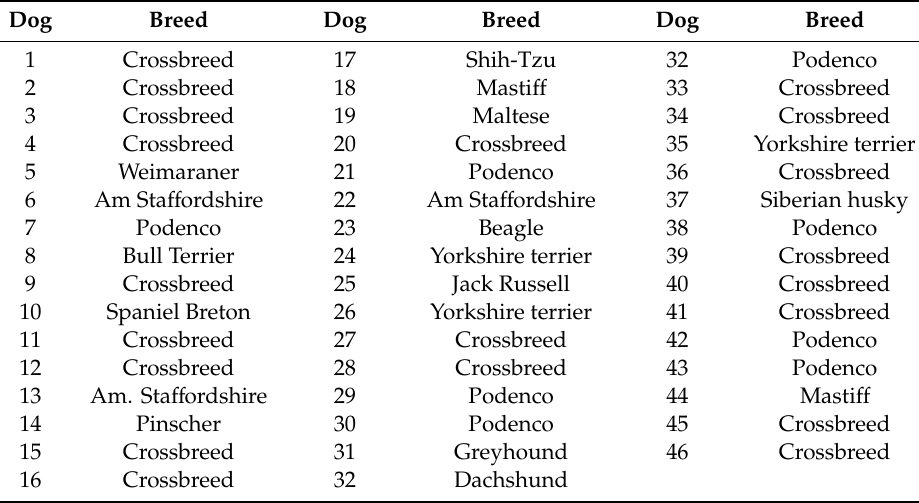
Table 1. Descriptive data of breed for each